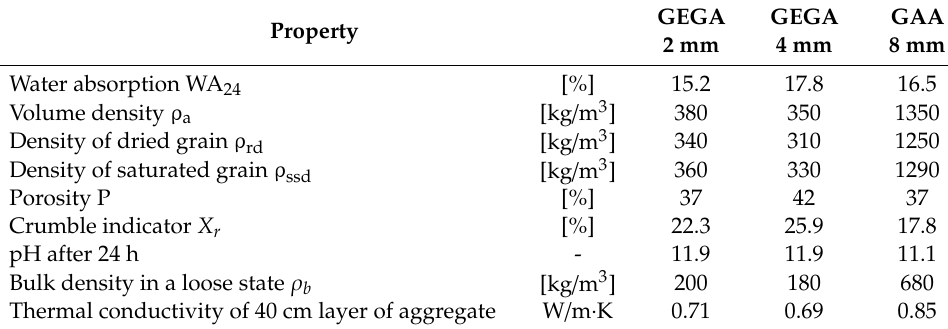
Table 2. Physical properties of the aggregates are presented in Table 3. Table 3. Physical properties of the aggregates [15].